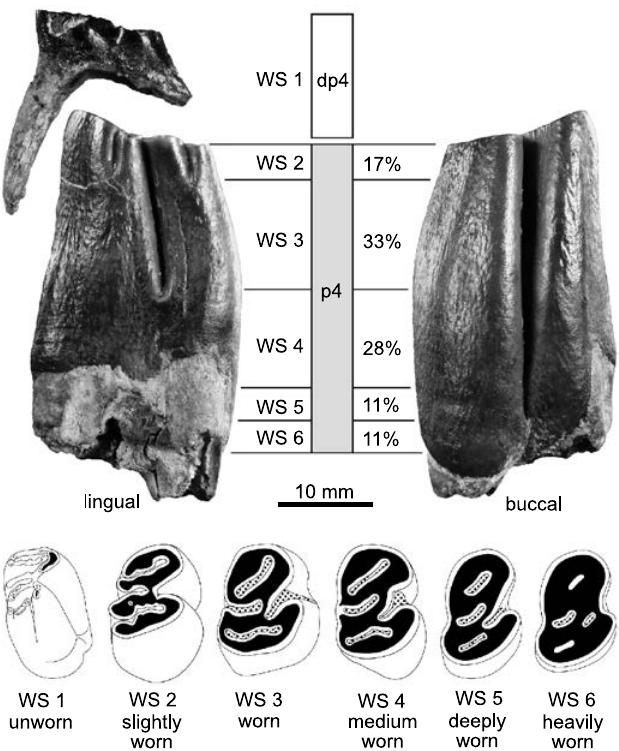
Fig. 10. Wear stages (WS) and step-length between between wear stages for the lower premolar dp4/p4 of the beaver Steneofiber depereti Mayet, 1908, from the early Late Miocene locality Hammerschmiede (Bavaria, Germany). The step-length of wear stages is given as an approximate percentage of the entire p4 tooth crown height (100%). Lower right dp4